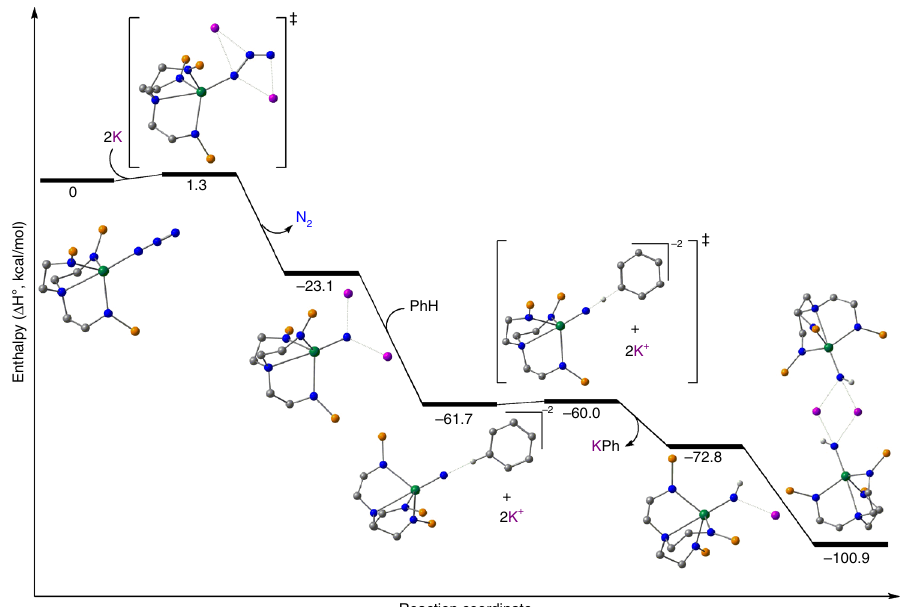
Fig. 5 Computed reaction pro fi le for the reduction of 2 by potassium in benzene. This pathway accounts for the reduction of the azide to nitride then subsequent protonation from benzene solvent to give a parent imido, which dimerises in-line with experimental fi ndings. The iso-propyl groups of the silyl substituents are omitted for clarity. In this reaction scheme potassium rather than potassium graphite was used to give a tractable